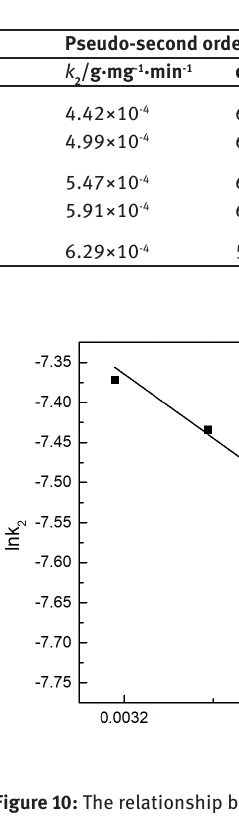
Figure 10: The relationship between lnk